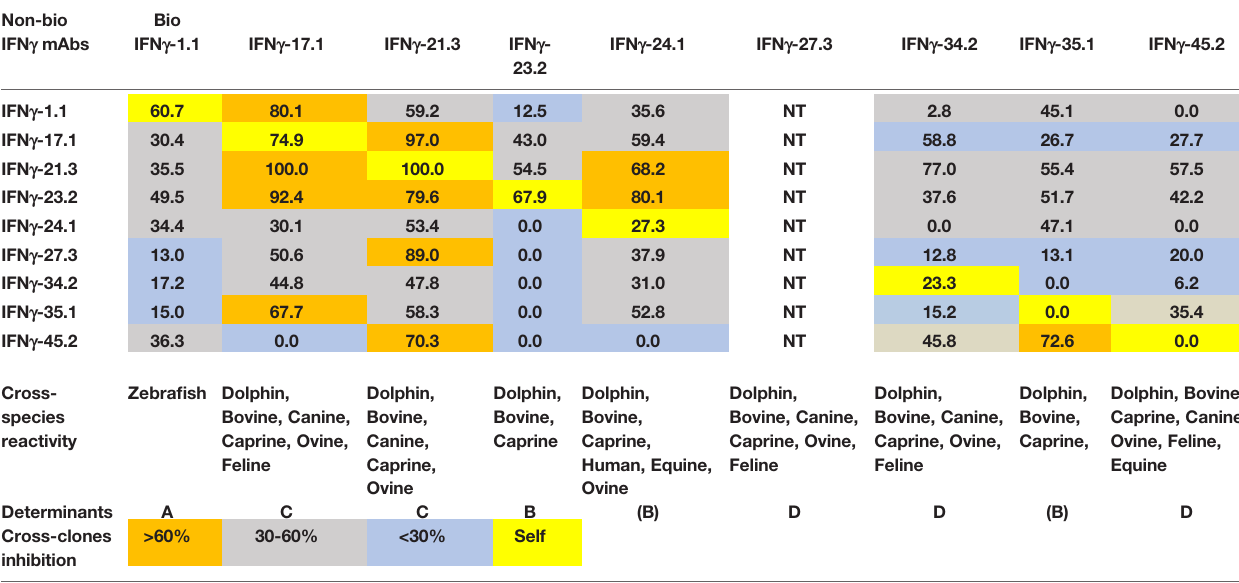
FIGURE 1 | Cross-species binding of a PoIL-17A mAbs. A panel of biotin-labeled a PoIL-17A mAbs were tested for their ability to bind to puri fi ed orthologous rIL- 17A proteins from species as described in M&M. Shown are mean ODs of duplicates for the binding of 1 m g/ml for each mAb. TABLE 3 | Assignment of anti-PoIFN g mAbs